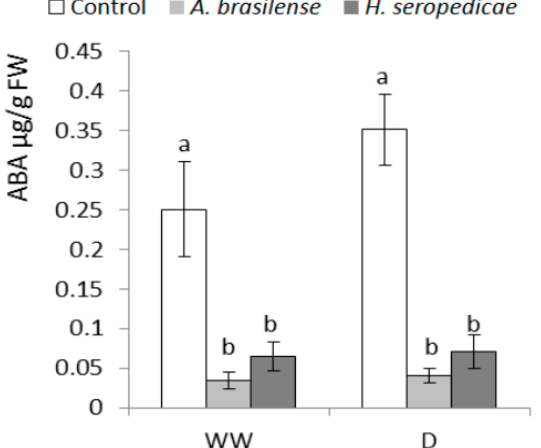
Figure 5. Abscisic acid (ABA) content 20 DAS. Data are shown as means ± SD ( n = 24). Means with common letters are not significantly different ( p > 0.05). The plants were cultivated under WW or D conditions. The inoculation * drought interaction p = 0.0908.